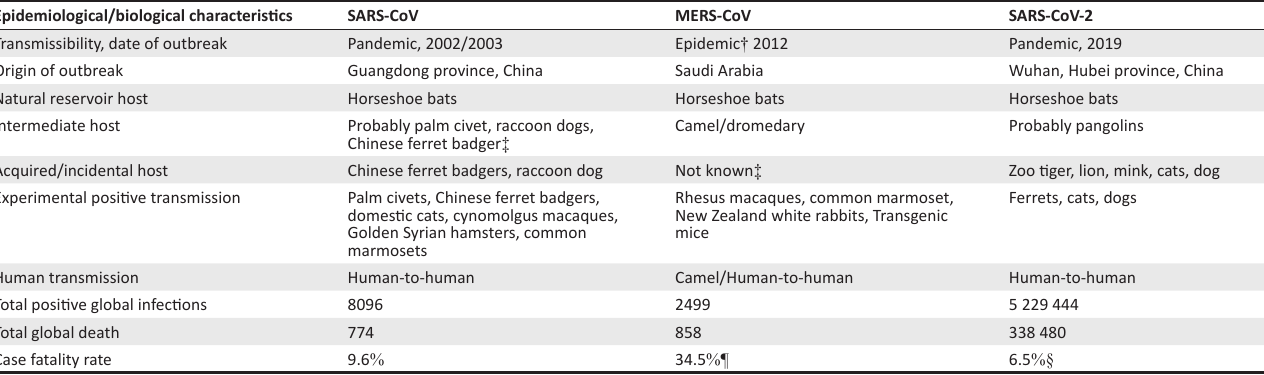
TABLE 1: Summary of epidemiological data for severe acute respiratory syndrome coronavirus, Middle East respiratory syndrome coronavirus and severe acute respiratory syndrome coronavirus 2. Epidemiological/biological